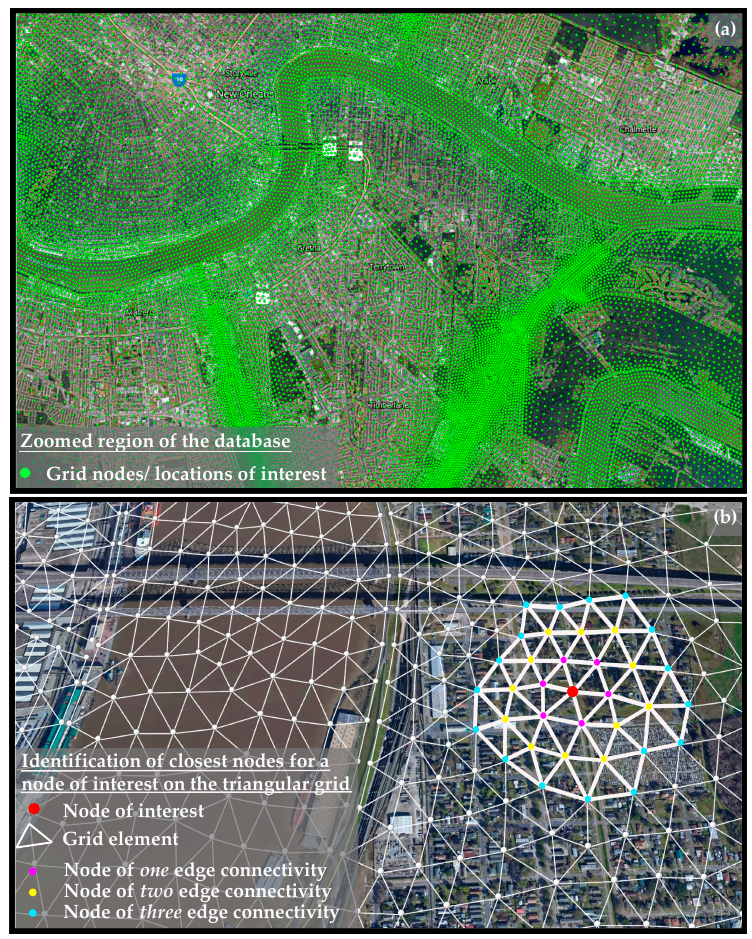
Figure 5. ( a ) Part of the grid of nodes that are included as output locations in the database focused on the New Orleans area, and ( b ) the process of identifying the closest nodes to an arbitrary node of interest using the node connectivity established by the ADCIRC triangular grid elements.